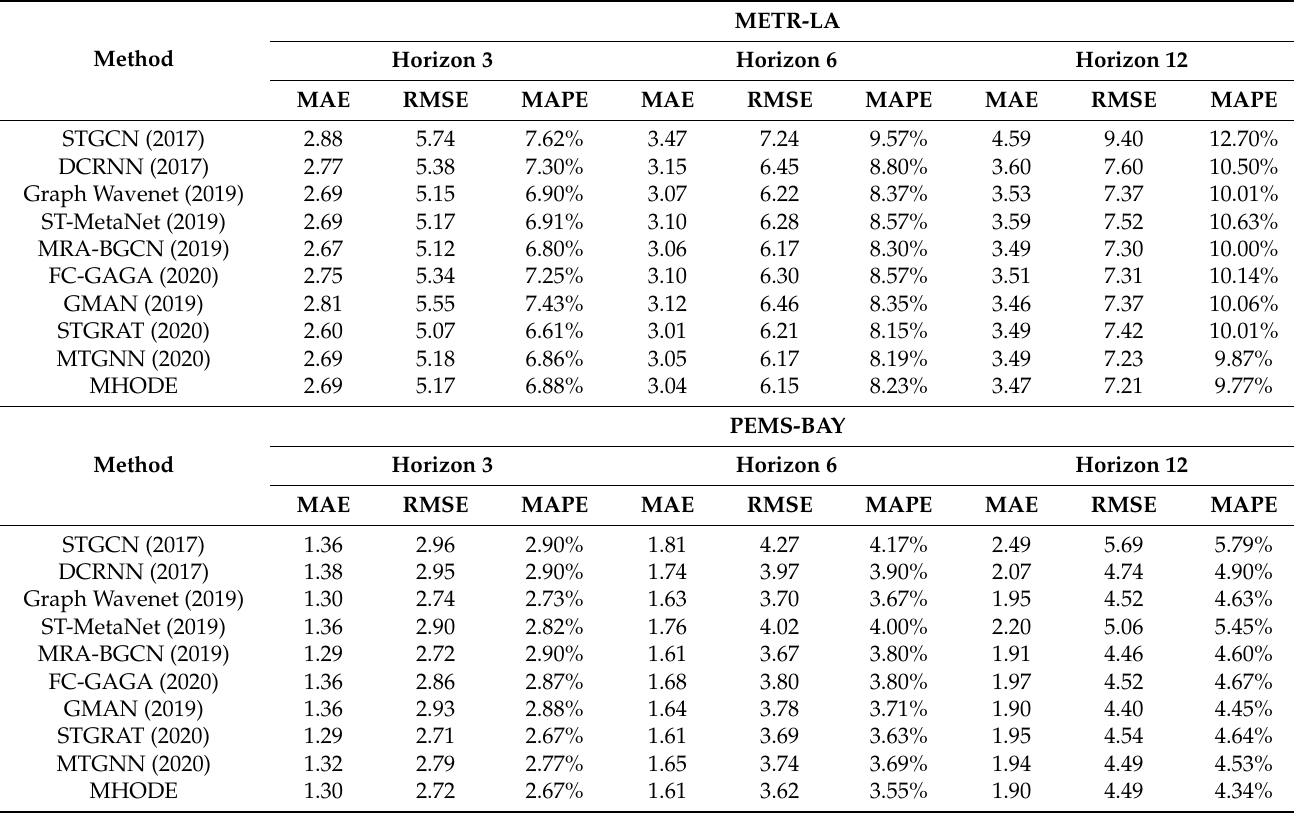
Table 3. Performance of MHODE compared to other baseline